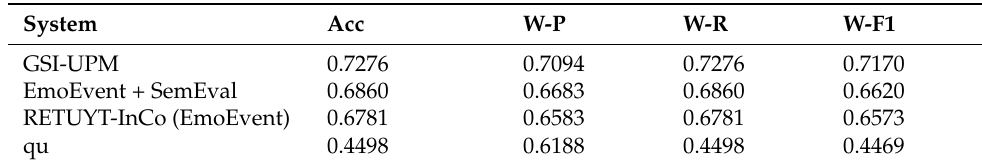
Table 4. Comparison of the best, worst, and our system (originally described in [8]) in the EmoEvalEs competition, together with the result of the new model trained with data from EmoEvent and SemEval. Metrics: Accuracy (Acc), Weighted Precision (W-P), Weighted Recall (W-R), and Weighted F1